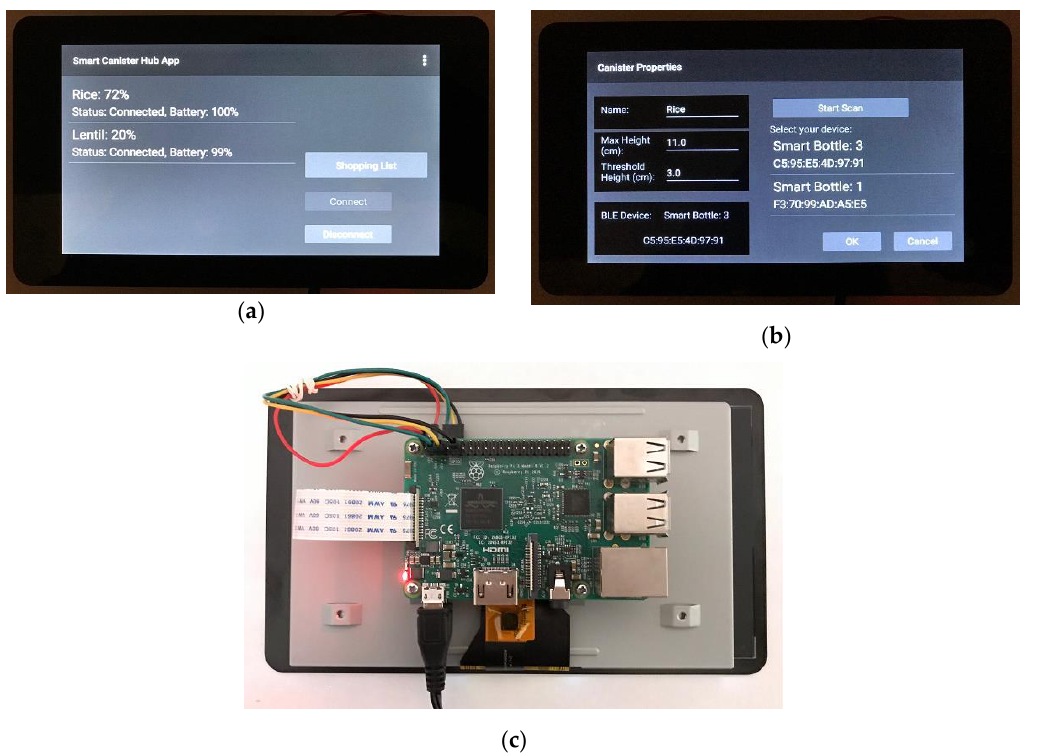
Figure 8. Photograph of the central hub—( a ) front screen showing item names in the canisters, connection status, and battery levels; ( b ) Configuration of canister properties; ( c ) bottom view— Raspberry Pi board interfaced with LCD. interfaced with